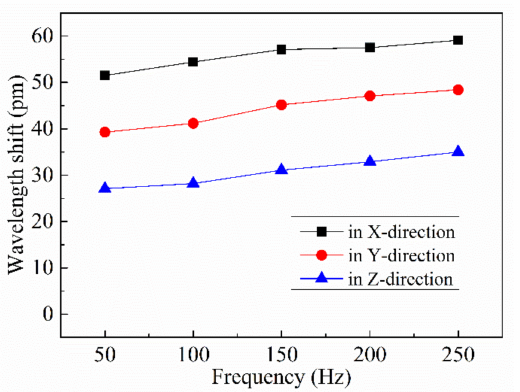
Figure 23. Wavelength shift versus frequency curves of the accelerometer when the vibration happens along a special direction (A X = 1 g, A Y = 1 g, A Z = 1.414